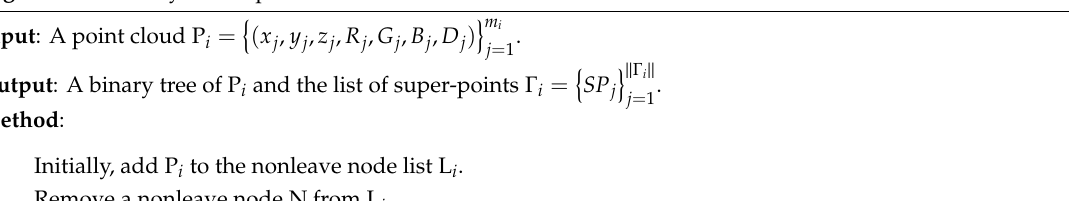
Algorithm 2. Binary tree Representation of Point Cloud with the MPPA